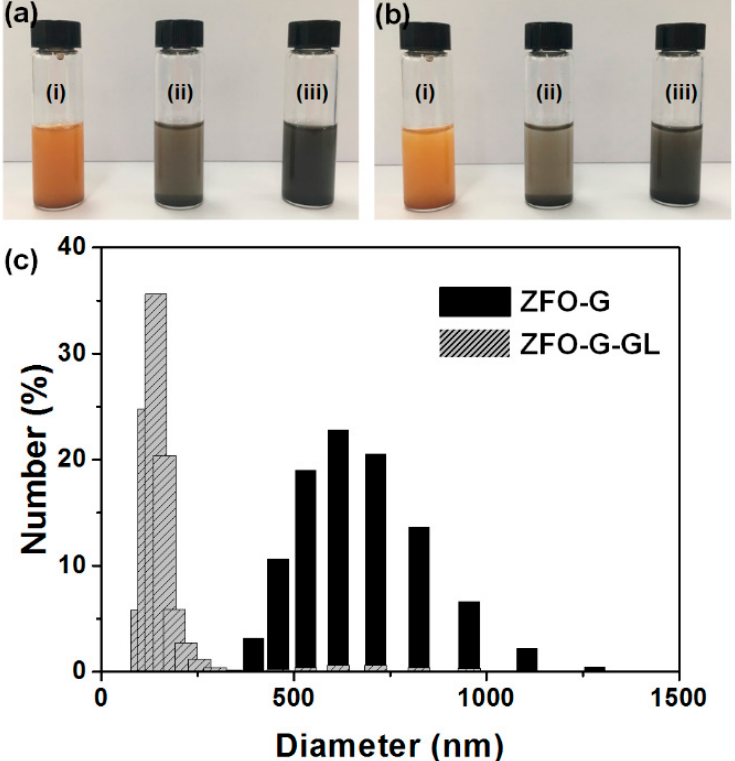
Figure 5. Suspension of (i) ZFO, (ii) ZFO–G, (iii) ZFO–G–GL in water ( a ) right after a shaking; ( b ) formation of precipitations after 5 min; and ( c ) particle size distribution of ZFO–G and ZFO–G–GL.